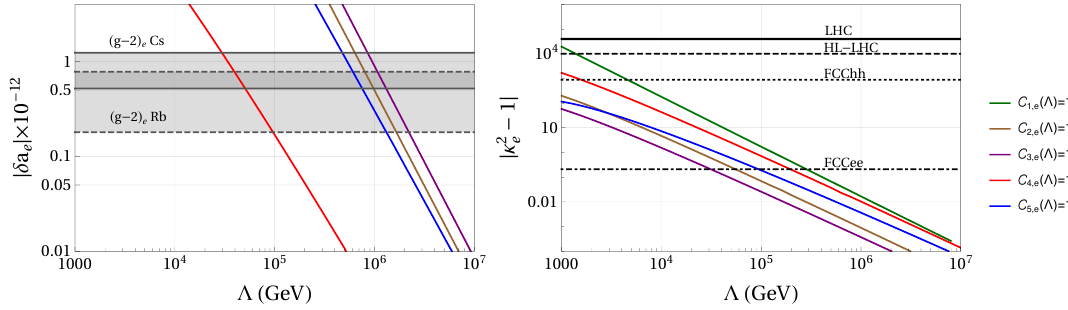
Figure 4 . Left : induced shift in the electron anomalous magnetic moment from δc 2 ,e as function of the NP scale Λ . The horizontal gray bands show the ( g − 2) e favored regions according to Cs (solid) and Rb (dashed) measurements. Right : induced shift in Higgs to two electrons decay from δc 1 ,e as function of the NP scale Λ . The horizontal solid line shows present bounds from measurements at LHC, while dashed, dotted and dotdashed lines show projections from HL-LHC, FCChh and FCCee